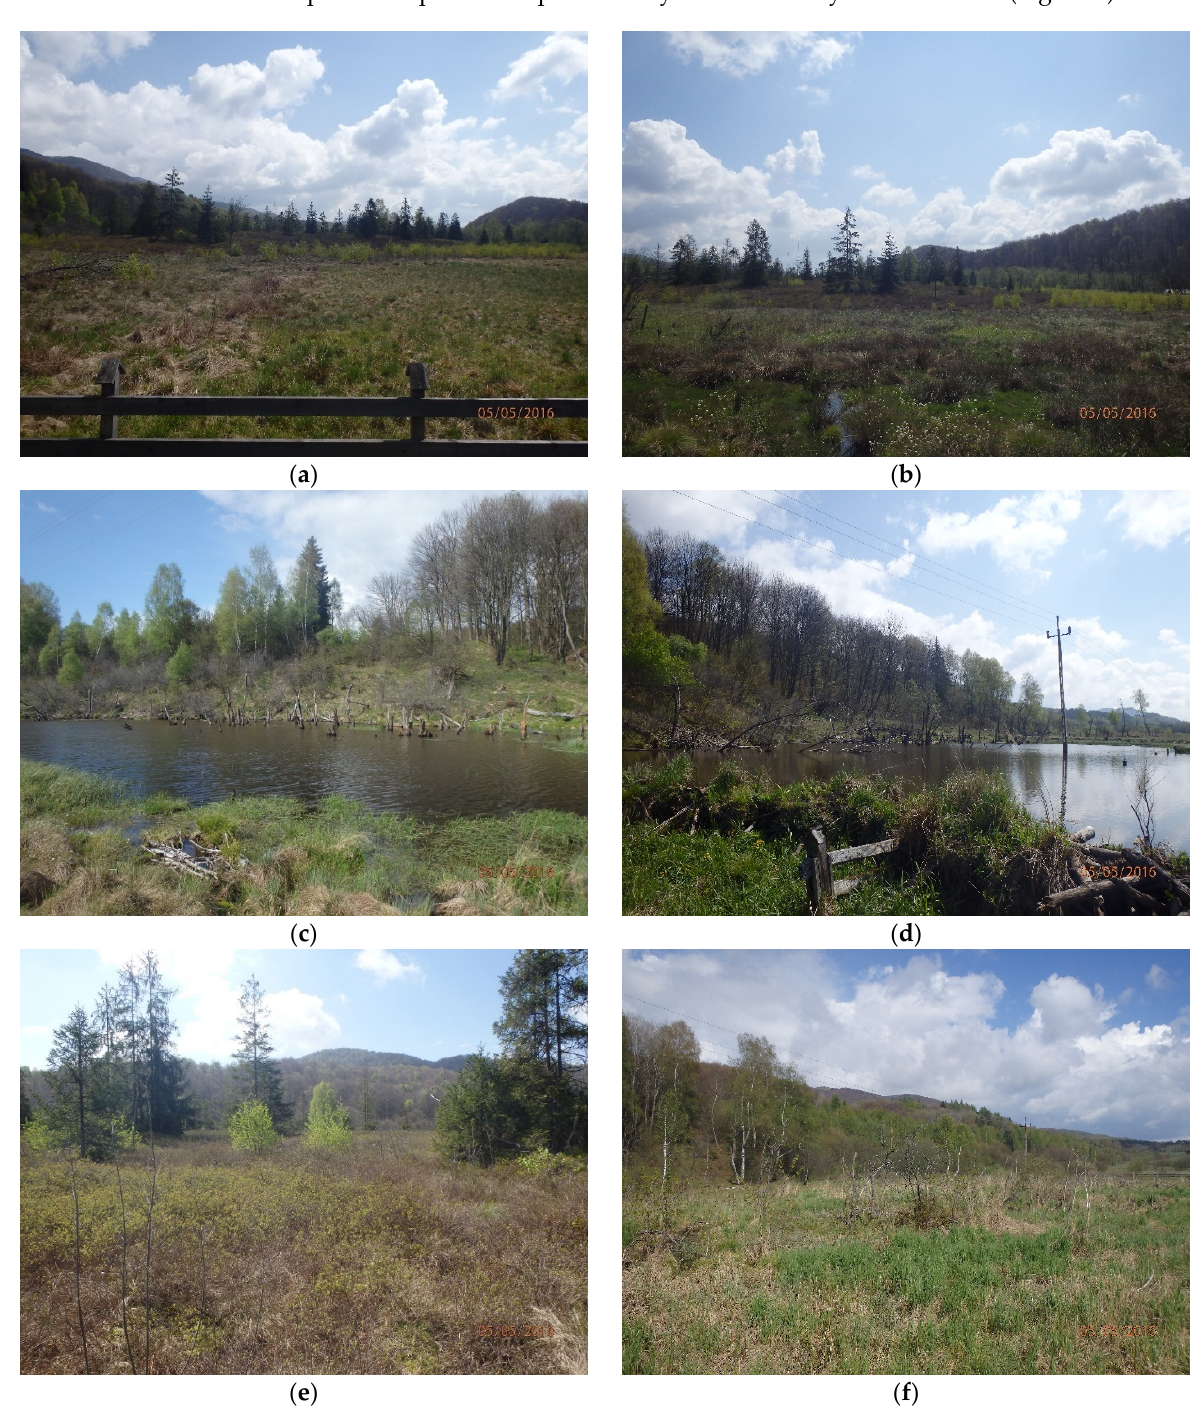
Figure 2. The panorama of the “Wołosate” raised bog in the Bieszczady National Park—( a , b ); a flood area on the edge of the “Wołosate” raised bog, created as part of protective tasks performed by the Bieszczady National Park in 2016—( c , d ); the effect of the drainage of the „Wołosate” bog ecotonal area—2016—( e , f